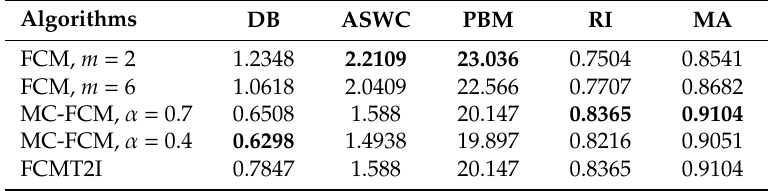
Table 4. Experimental results with the WDBC dataset, 569 samples, 2 clusters, m L = 3.1, m U = 9.1.